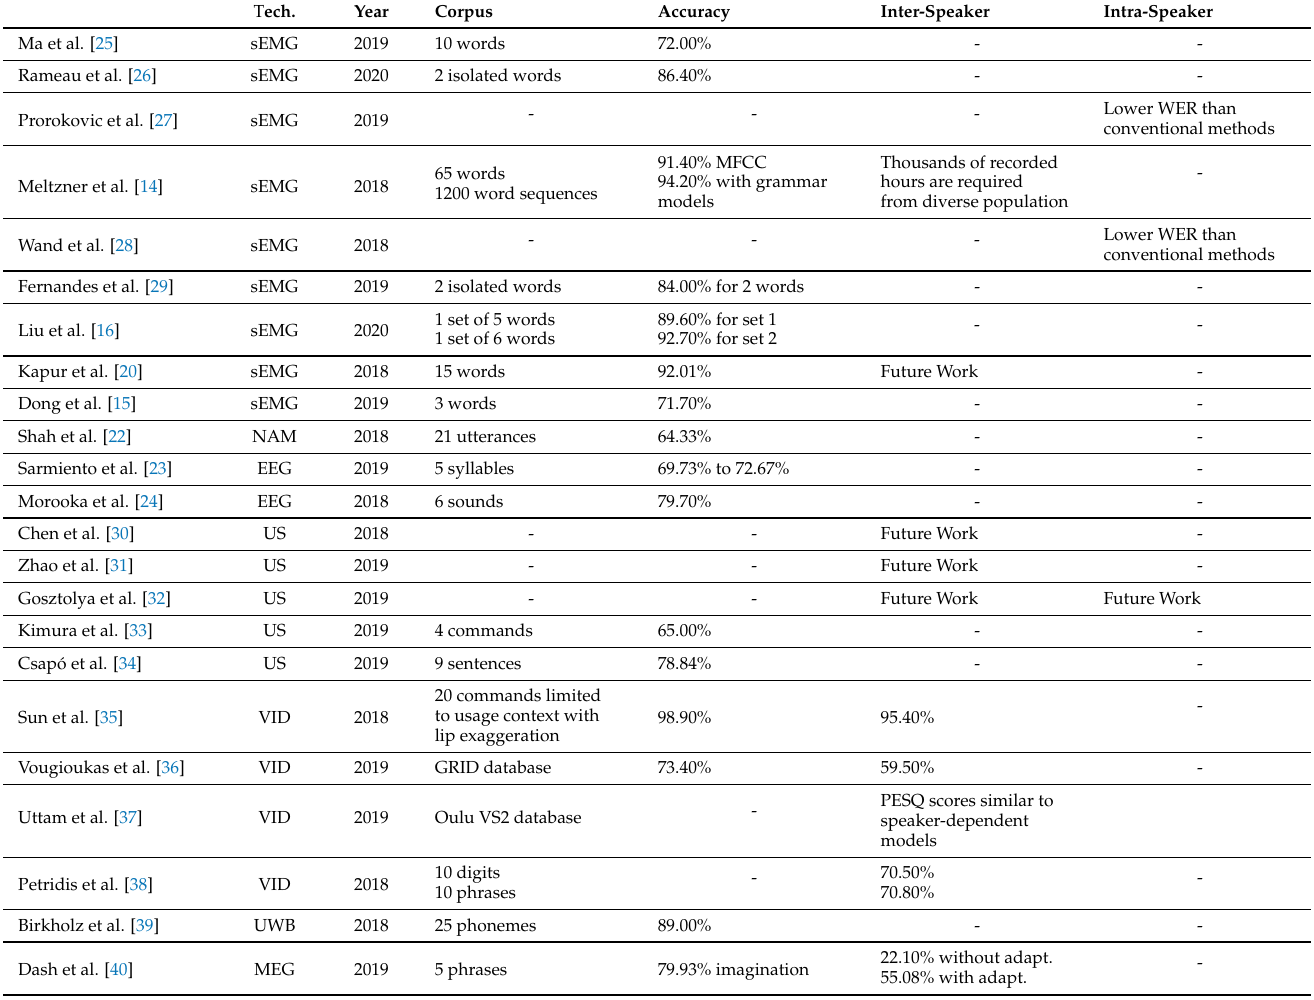
Table 1. Notable recent studies tackling silent speech recognition and the outcomes regarding speaker and session independence. Apart from stating the considered technology, for each study, its publication year and acquisition corpus (when applicable) are also